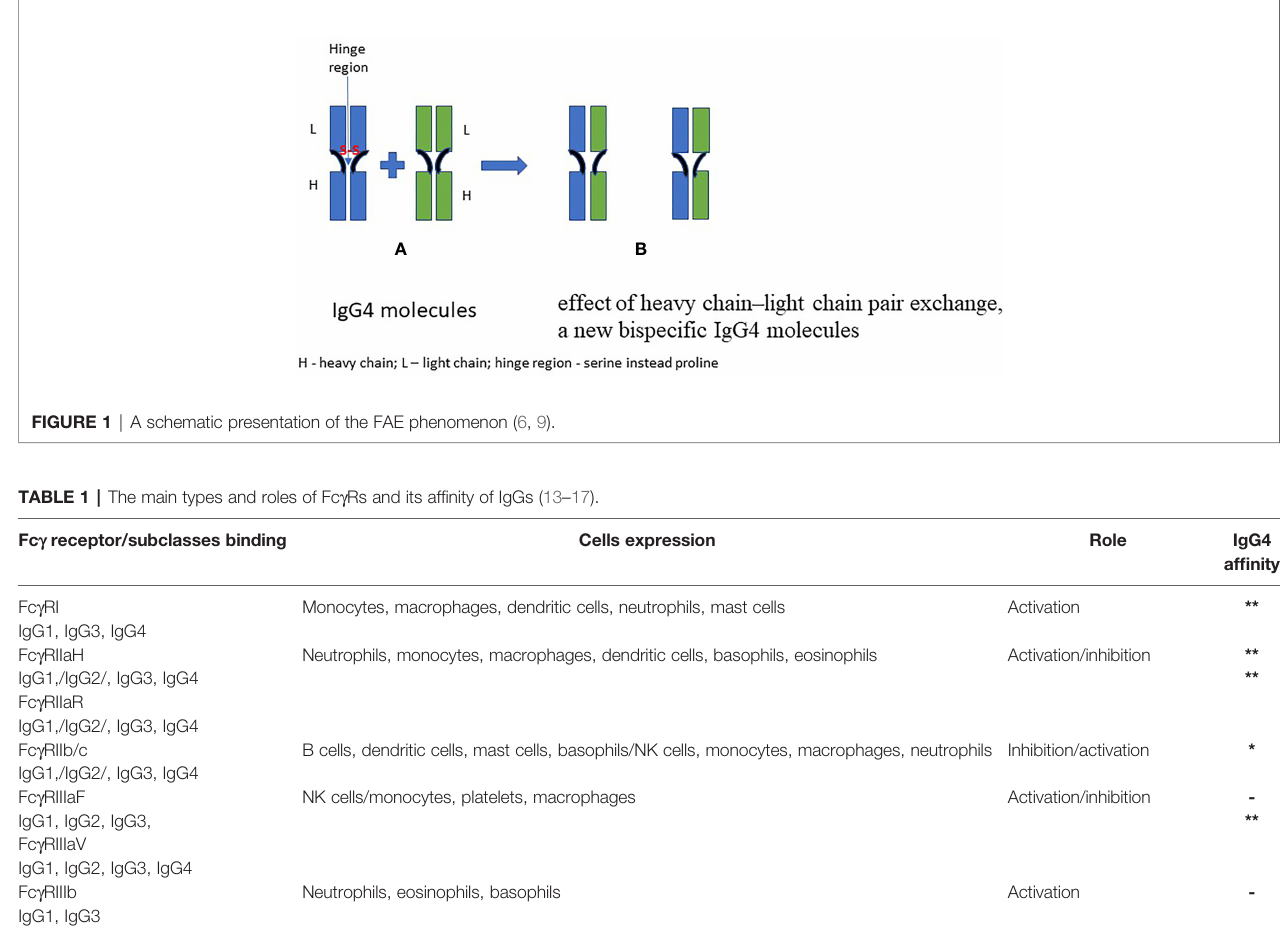
Activation/inhibition